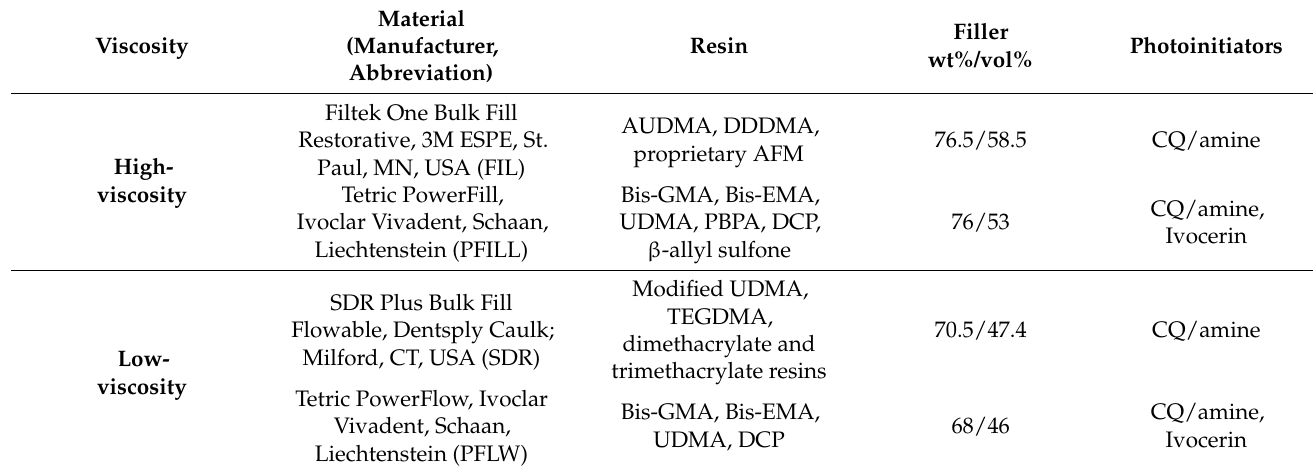
Table 1. Composition of tested materials provided by the